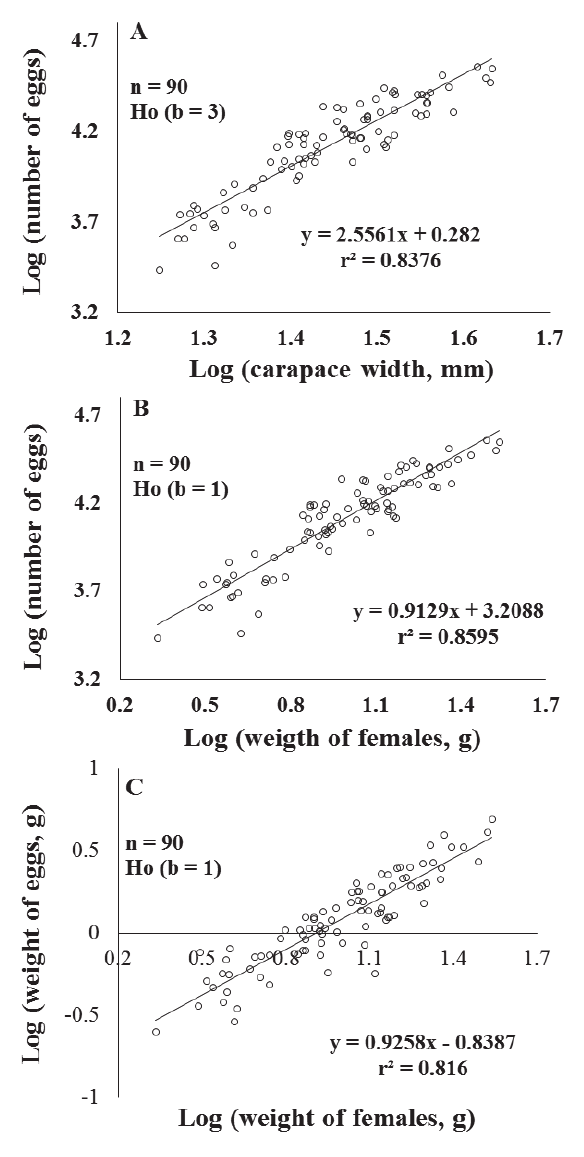
Figure 3. Eriphia gonagra (Fabricius, 1781). Allometric relationships: A. log egg number (EN) vs . log carapace width (CW); B. log egg number (NE) vs . log female weight (FW); and C. log eggs weight (EW) vs. female weight (FW).